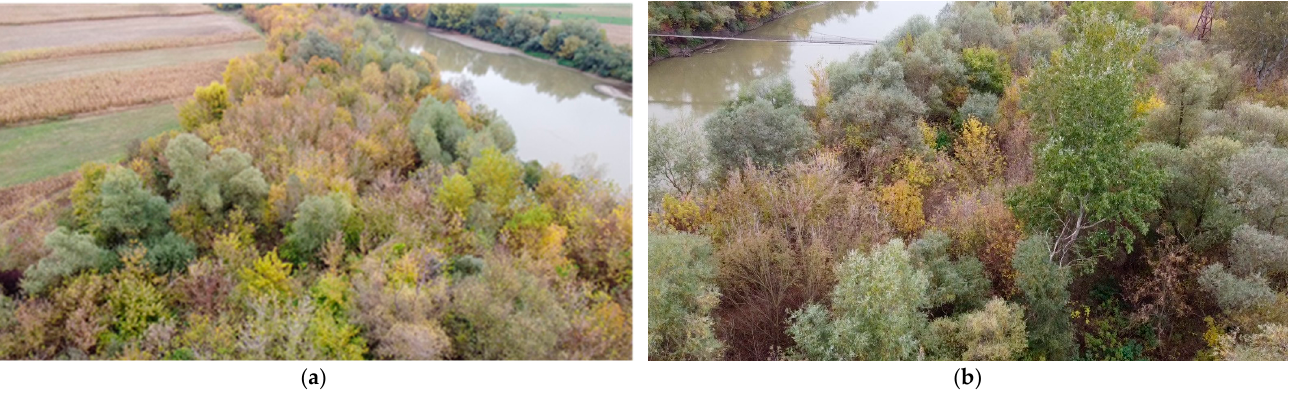
Figure 3. Overview presenting the vegetation characteristic for the investigated riparian forest strips (aerial images acquired using the drone): ( a ) Research area inside the N2000 network; ( b ) Research area outside the N2000 network.